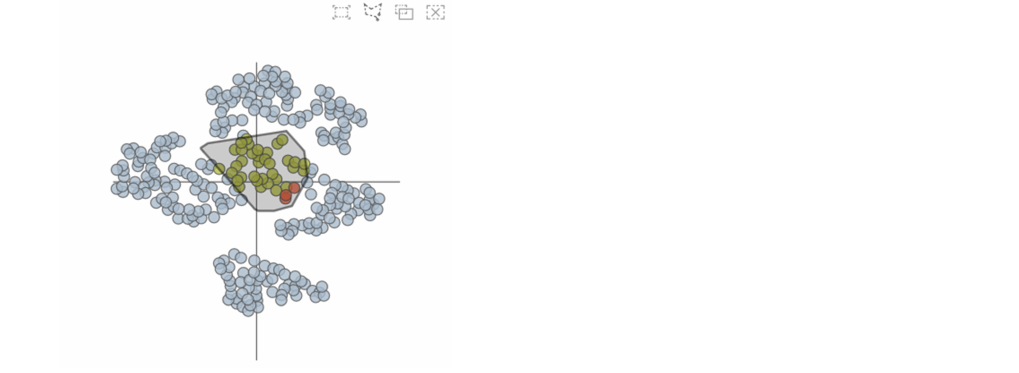
Figure 6. The AAFS Clustering View shows the results after dimensionality reduction & clustering.